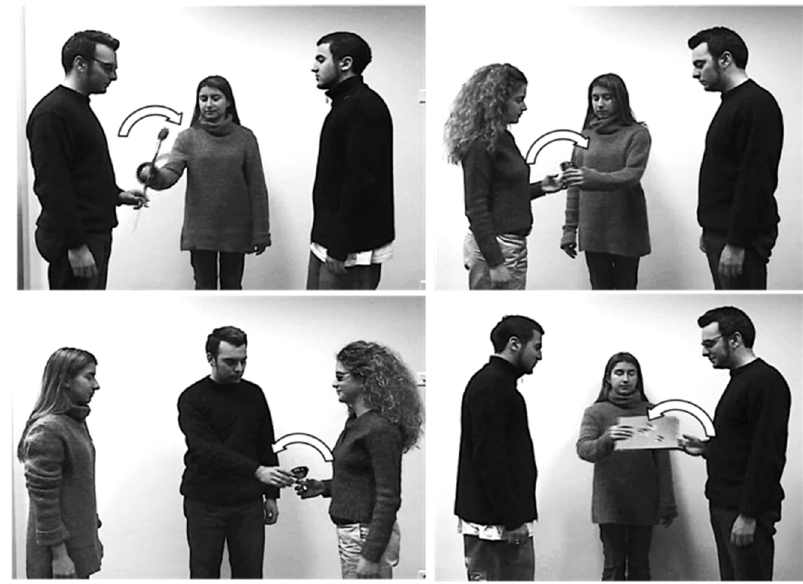
Figure 1. Stills of some of the video stimuli used in the task.